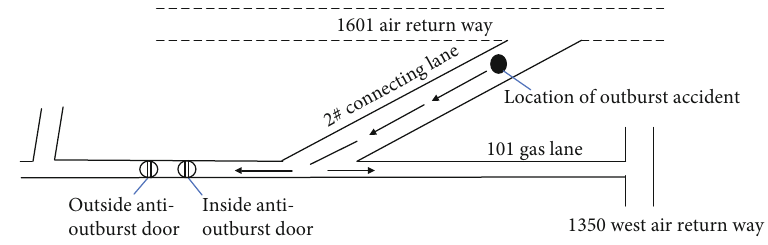
Figure 5: Schematic diagram of the 6.11 outburst accident site in Liuzhi Xinhua Coal Mine,